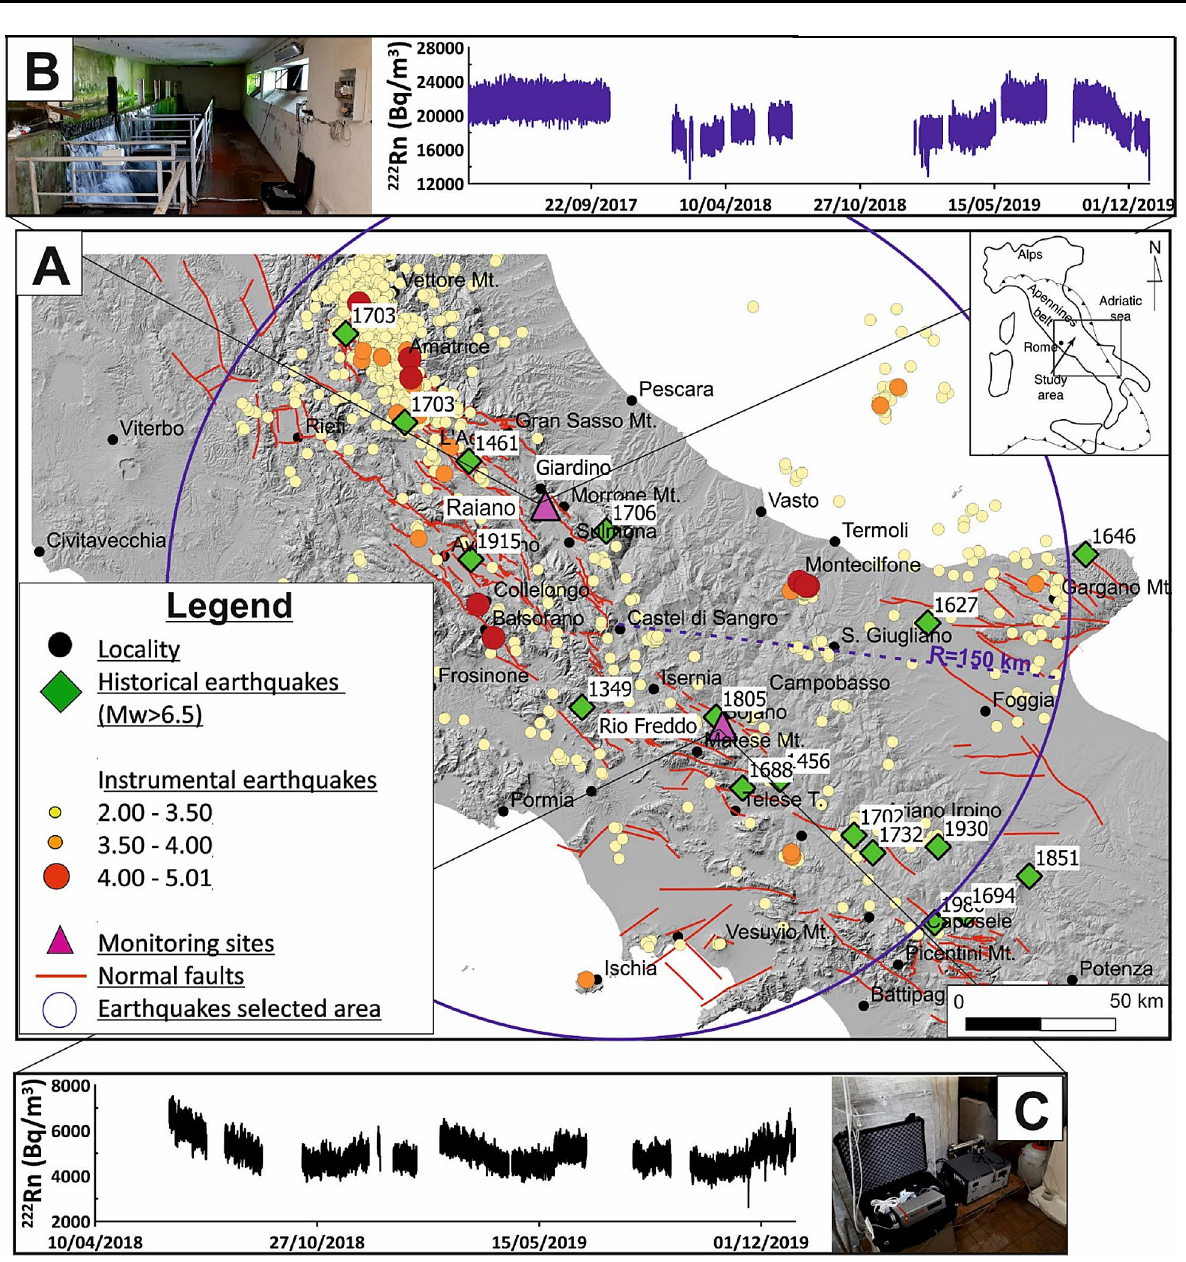
online at http://terre moti.ingv.it/). B AlphaGUARD probe (left) and Fig. 2 A Map of central-southern Apennines, Italy. Location of time series (1 April 2017–31 December 2019) of Rn concentrations springs is displayed with cyan triangular symbols. Earthquakes (1 (right) at SG. C AlphaGUARD probe (right) and time series (1 June April 2017–31 December 2019) occurred in the study area are dis- 2018–31 December 2019) of Rn concentrations (left) detected at played with circles of different size and colour depending of their magnitude. Historical earthquakes ( M ≥ 6.5) are shown with green w rhombuses. Seismic data are from the INGV database (available